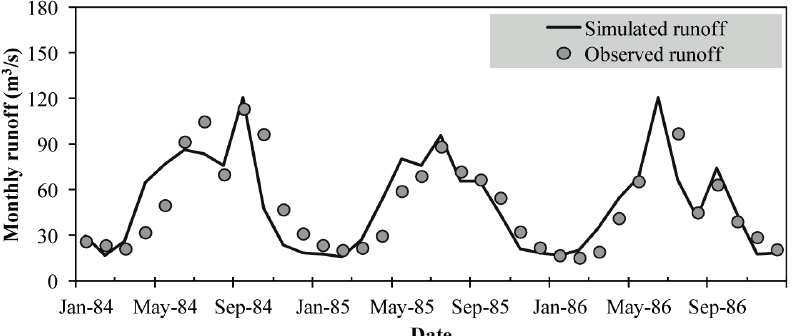
Fig. 3 Comparison of simulated and observed runoff for calibration period.